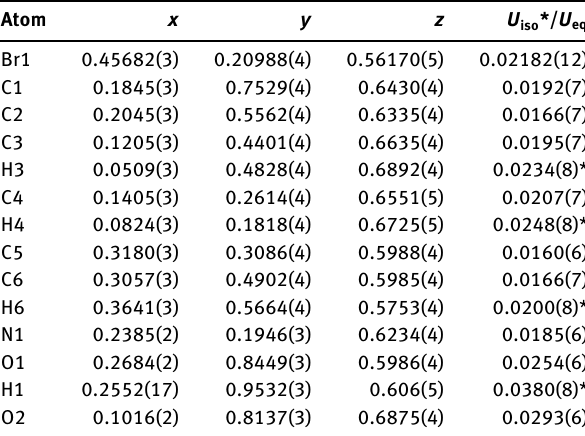
Table 2: Fractional atomic coordinates and isotropic or equivalent isotropic displacement parameters (Å 2